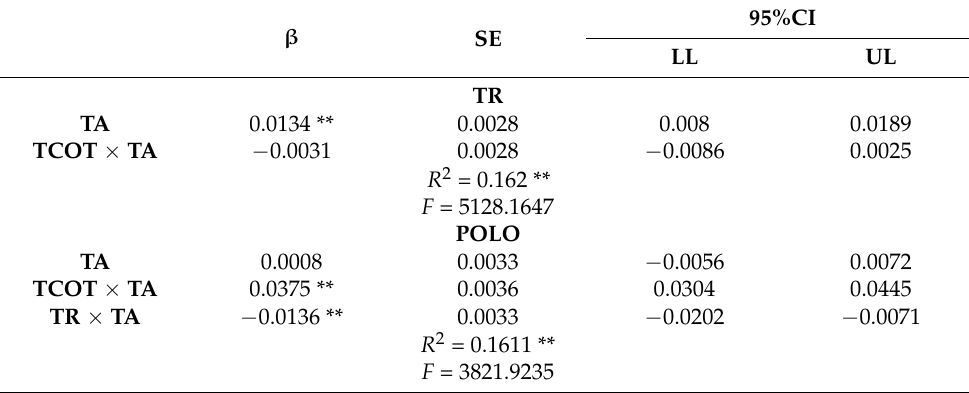
Figure 2. Moderated-mediation role of teachers’ age. (Source: drawn up by the authors). Table 4. The coefficients of the moderated-mediation analysis.